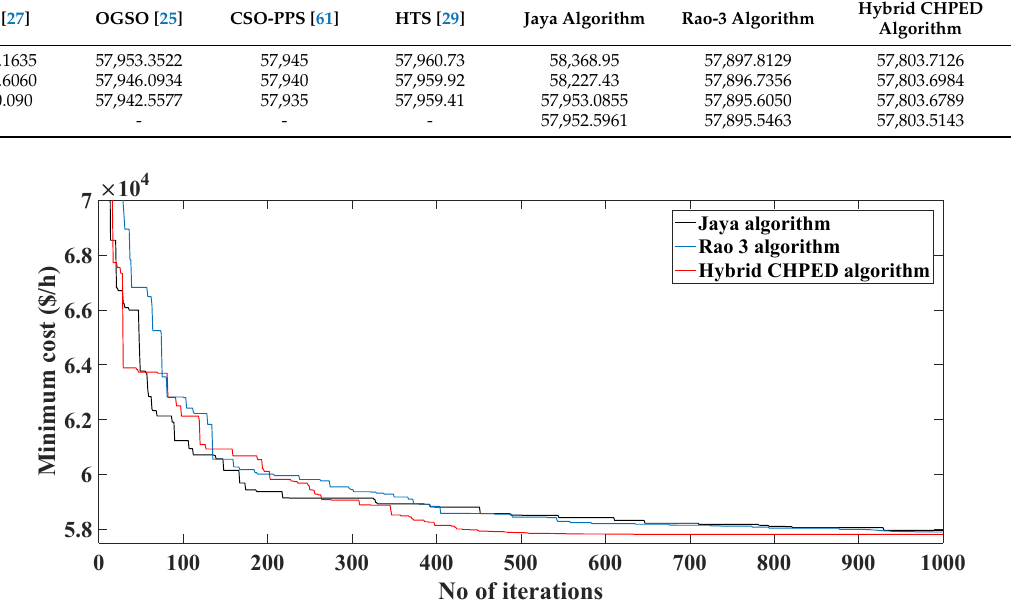
Table 6. Statistical analysis of case 2 of test system 2 .